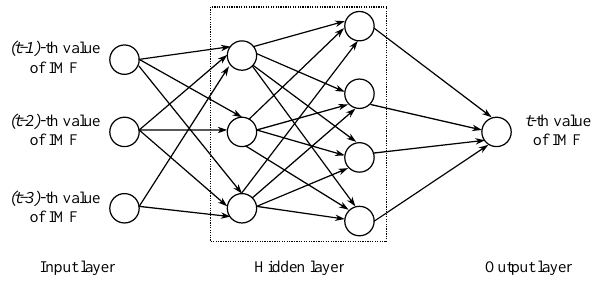
Figure 3. The back-propagation artificial neural network. Figure 4. Four-tier structure BPANN to simulate the IMFs of